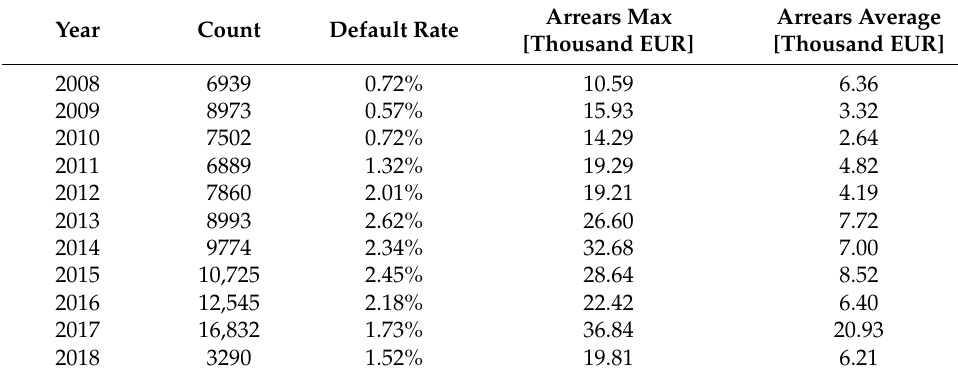
Table 2. Default rate and arrears